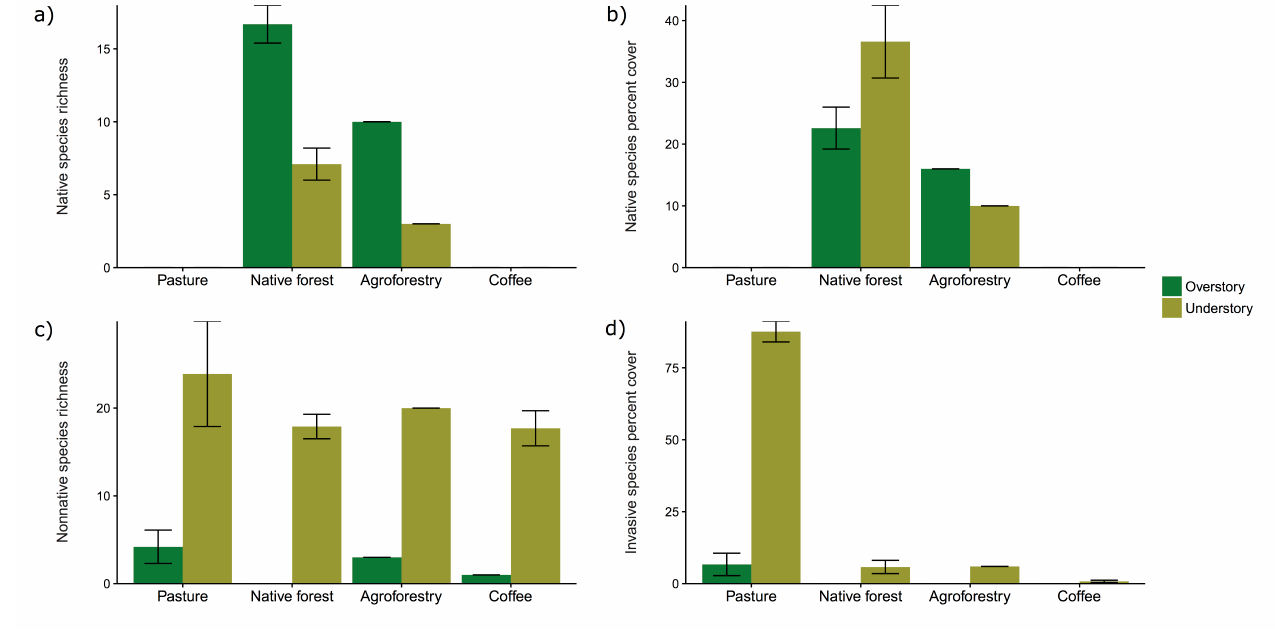
Fig. 4. Native and nonnative species richness (a,c) and vegetation cover (b,d) by land use. Values are means ± 1 SE. Nonnative species richness includes both introduced and invasive